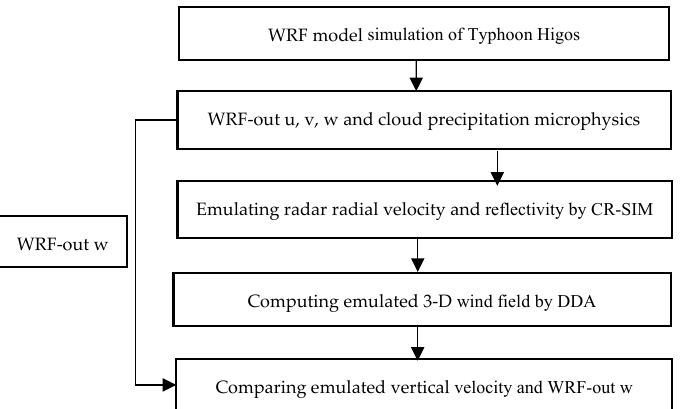
Figure 3. A flow chart of OSSE for validating the retrieval accuracy of the vertical velocity by the DDA method.